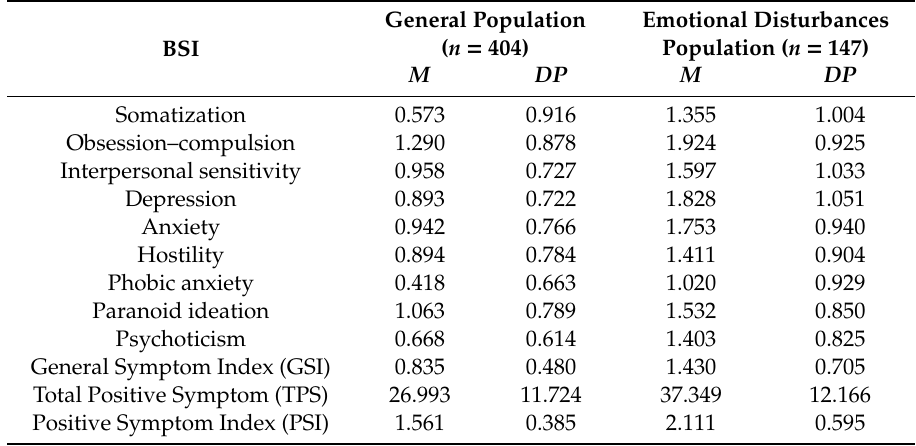
Table 1. Normative values of Brief Symptom Inventory (BSI) subscales and indexes of the Portuguese version of the BSI by Canavarro [42] in 2007.